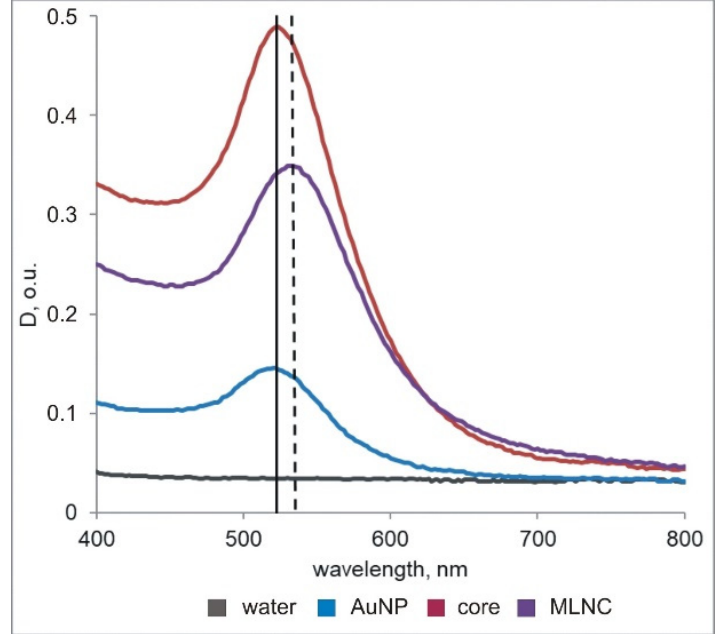
Figure 2. “Typical” spectra of the obtained samples of AuNPs, core nanoparticles, and MLNCs. The vertical lines indicate absorption maxima for AuNPs and core nanoparticles (520 nm, left-hand line) and for MLNCs (532 nm, right-hand line). For clarity, we present the spectra of the samples at concentrations that ensure resolution of the lines in the graph.